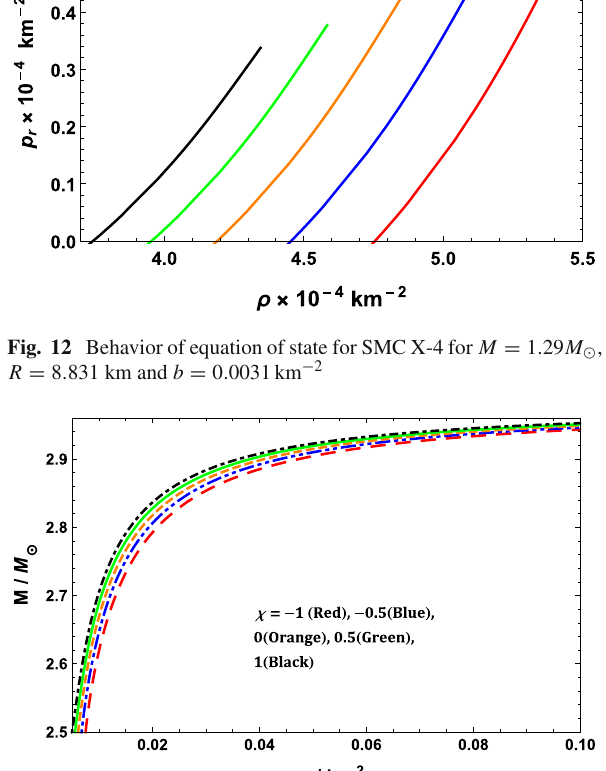
Fig. 10 Stability factor ( v 2 t − v 2 r ) profiles of SMC X-4 for M = 1 . 29 M (cid:9) , R = 8 . 831 km and b = 0 . 0031km − 2